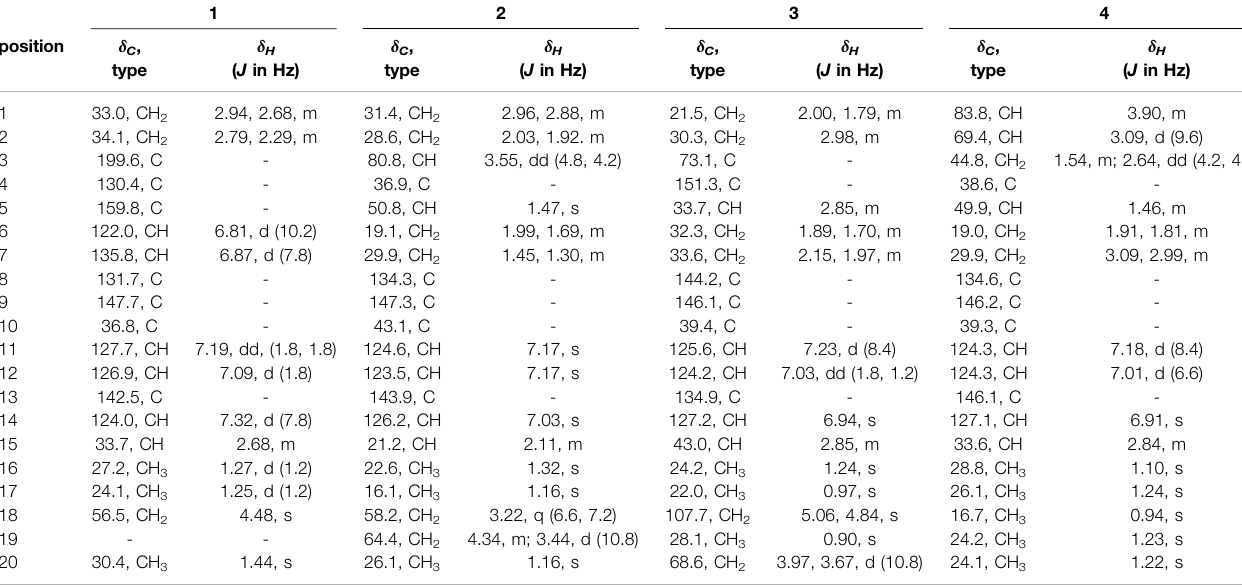
TABLE 1 | NMR spectroscopic data for compounds 1 – 4 (600 MHz for 1 H NMR and 150 MHz for 13 C